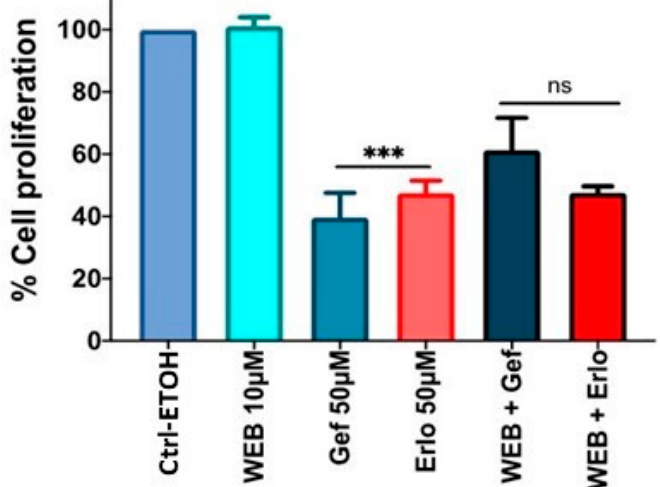
Figure 6. Effect of CPAF on targeted therapy-mediated decreased A549 cell proliferation. A549 cells were pre-treated with CPAF (100 nm, 1 h), followed by treatments with ± 0.1% ETOH, Gef or Erlo at given doses. After 72 h of incubation, the cell proliferation was analyzed via the CV assay. Data are expressed as the mean ± SE of three separate experiments. Statistically significant differences were observed, according to one-way ANOVA with the Bonferroni post hoc test, between Ctrl-ETOH and CPAF (** = p < 0.01), Ctrl-ETOH and Gef 50 µM or Erlo 50 µM (*** = p < 0.001), and according to Student’s t -test between Gef vs. CPAF + Gef (# = p < 0.01) or Erlo and CPAF + Erlo (£ = p < 0.001).